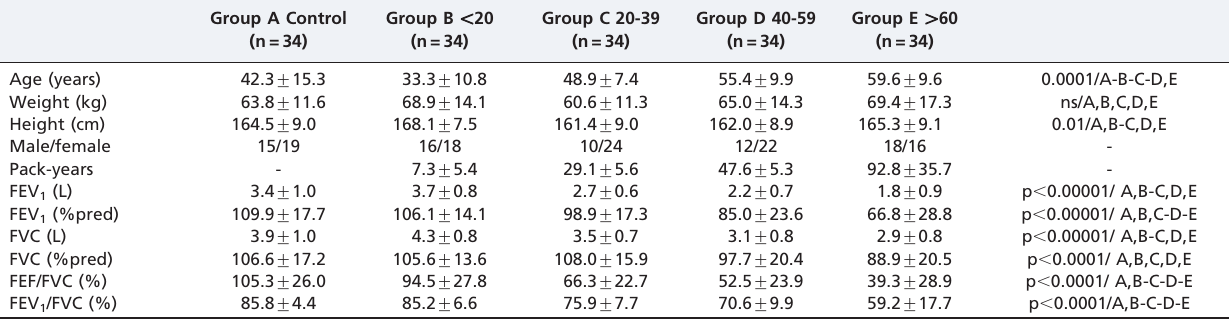
Table 1 - Biometric and spirometric parameters of the investigated